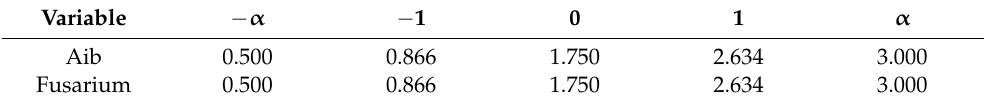
Table 1. Independent variable levels for the central composite